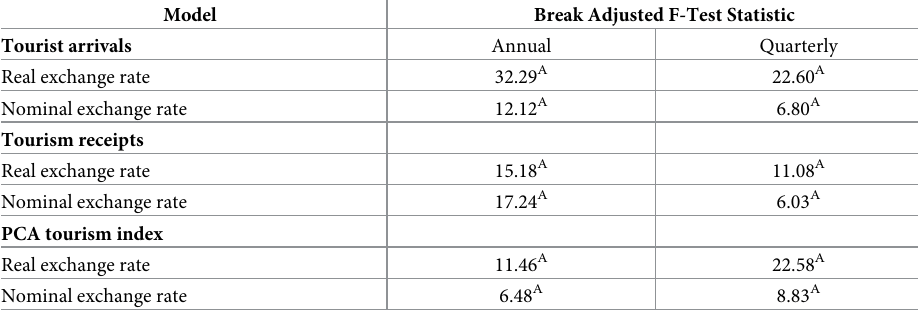
Table 6. Bounds test.